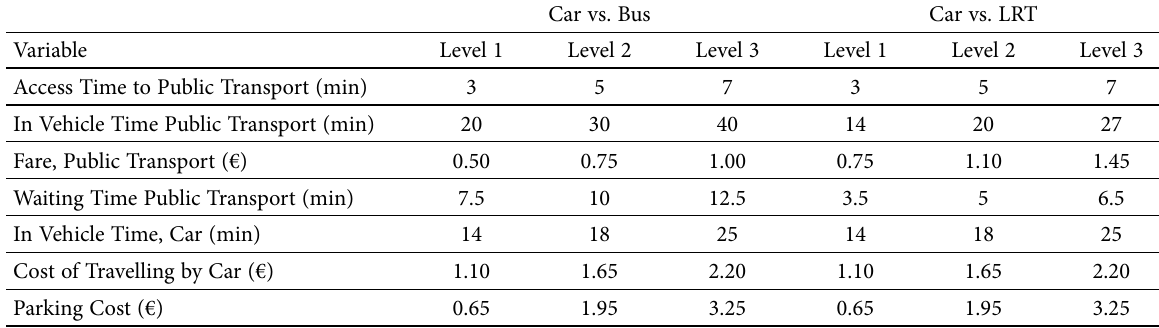
Table 2. Experimental Design: variables and values of the attributes of the Bus and LRT Car vs. Bus Car vs. LRT